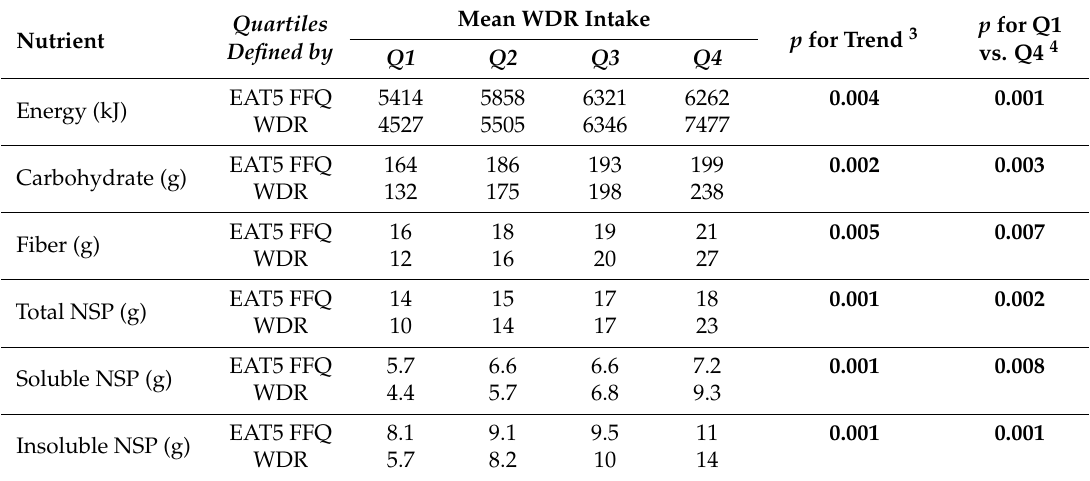
Table 4. Ability of the EAT5 FFQ to differentiate between quartiles of WDR intake, determined using actual values for surrogate categories ( n = 100) 1,2